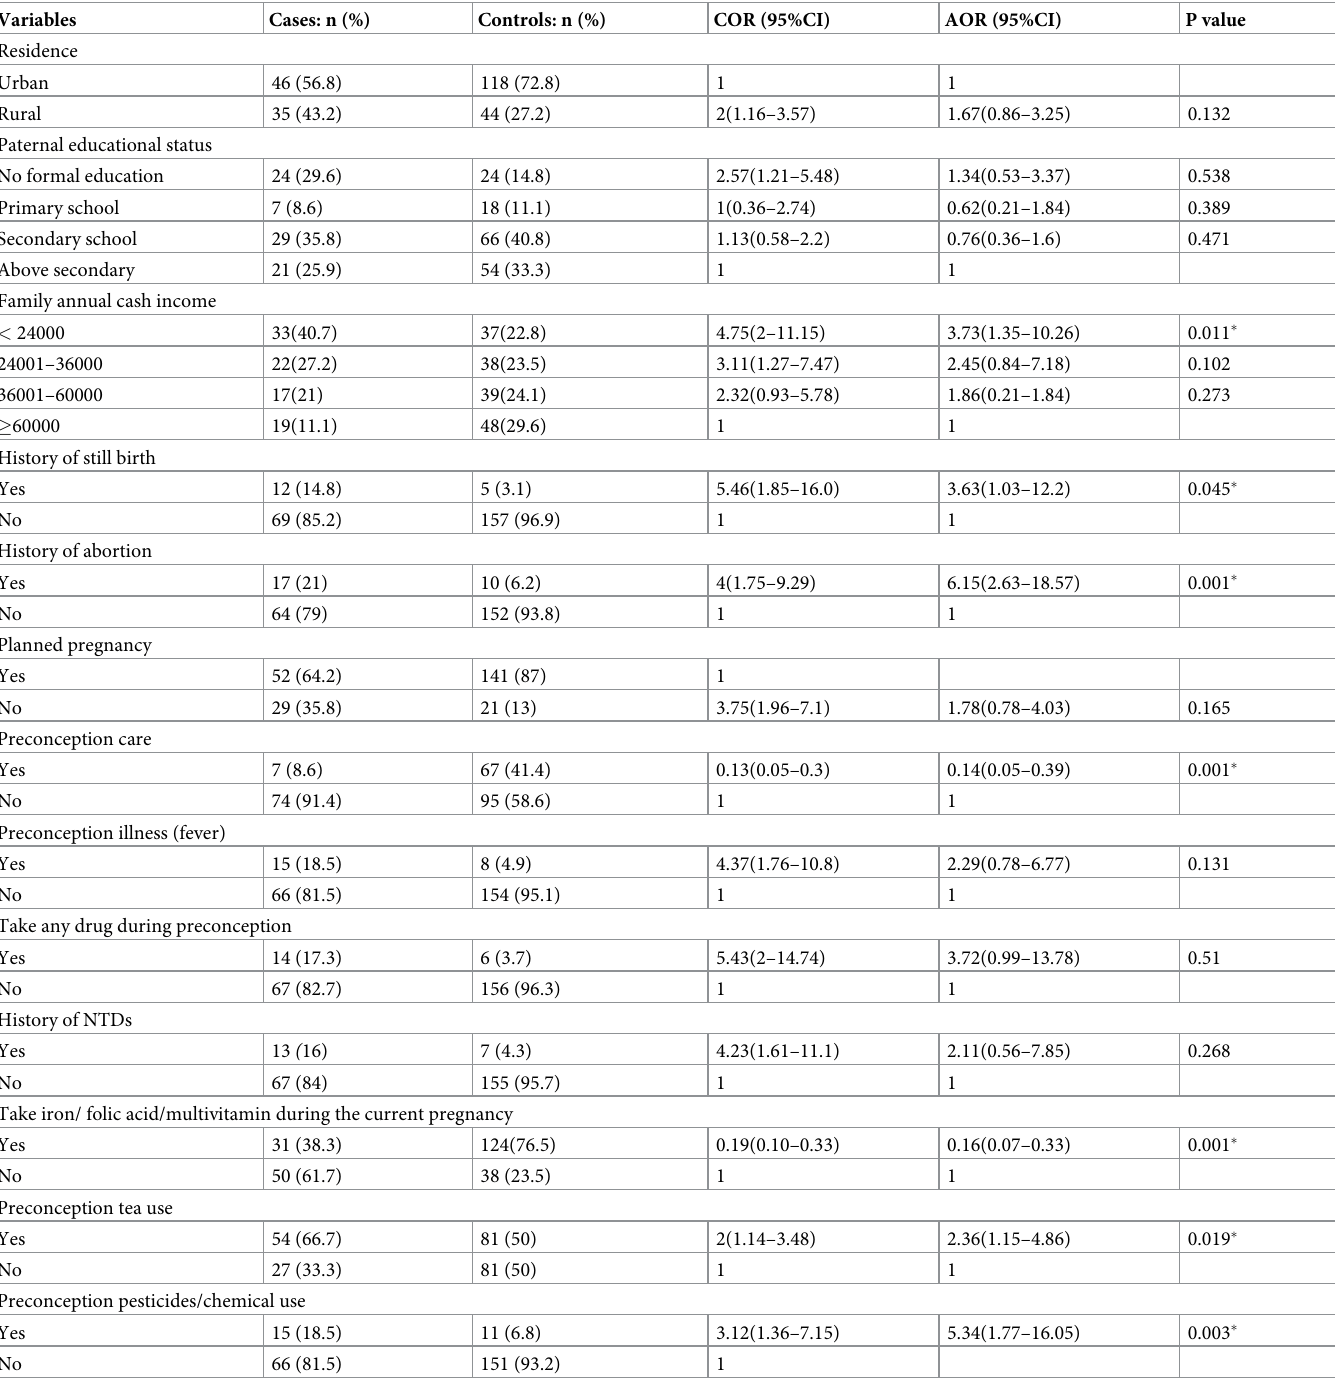
Table 5. Factors associated with NTDs among mothers who gave birth in North Shoa Zone Hospitals; Amhara Region, Ethiopia, 2020.